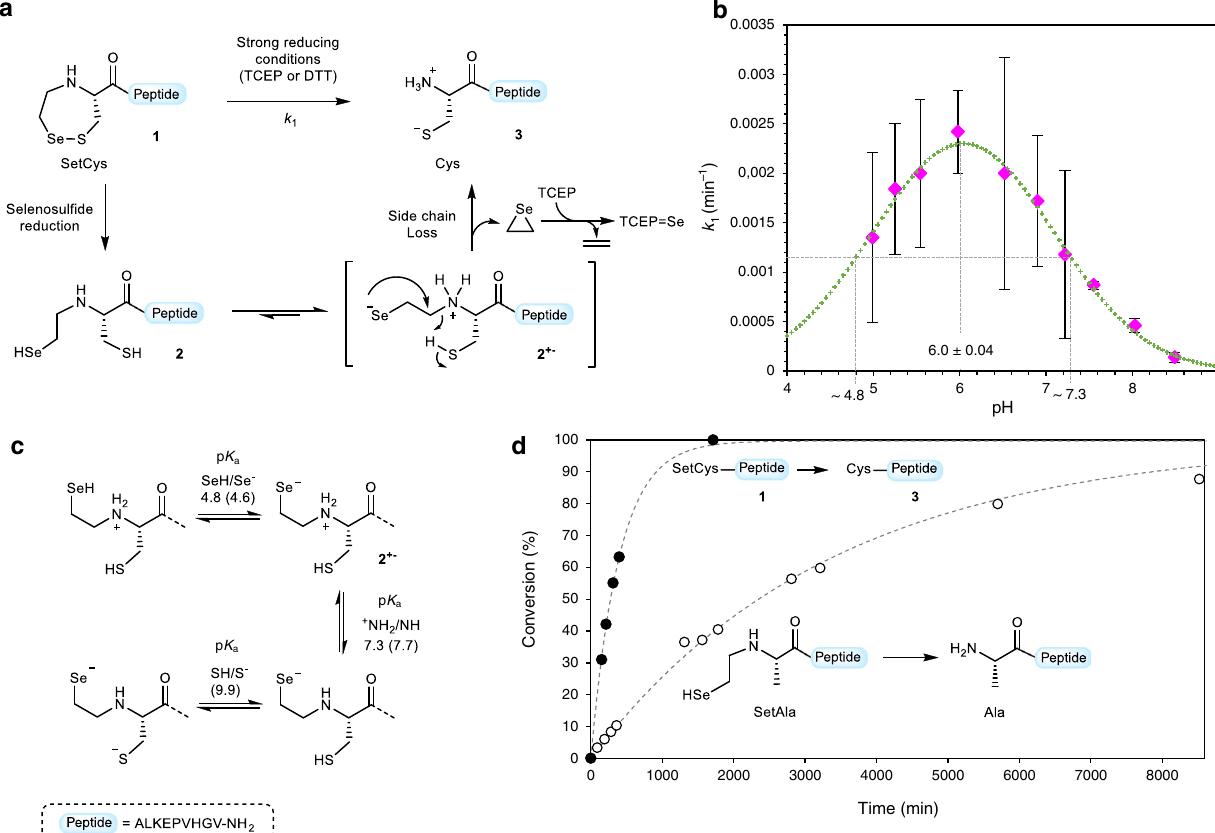
Fig. 3 Insights into the conversion of SetCys to a Cys residue. a Proposed mechanism for the loss of the N -selenoethyl appendage of N-terminal SetCys peptides. b Experimental pH – rate pro fi le of the conversion of N-terminal SetCys peptide to the corresponding N-terminal cysteinyl peptide (magenta diamonds). Each of the 10 data points represents the value of the reaction rate k 1 obtained from different reactions conducted at the considered pH (1 mM minimization. Associated standard errors (SE) were estimated based upon the covariance matrix resulting from nonlinear regression fi tting (Supplementary Table 3). Data are presented as mean values± SE. The data were then fi tted to a Gaussian (green curve) to determine the pH values for the in fl exion points (pH 4.8 and 7.3). c Different ionization states for the SetCys residue in open form. The numbers on the arrows correspond to the in fl exion points determined in Fig. 3b and to p K a values calculated using ACDLabs ® software (in parenthesis). d Rate of 2-selenoethyl limb cleavage